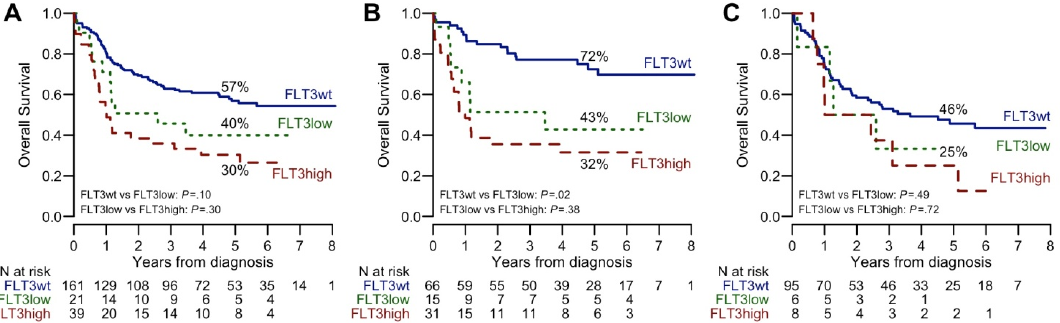
Figure 5. Kaplan-Meier curves of Overall Survival (OS), according to FLT3 -ITD ratio. ( A ) All patients; ( B ) NPM1 positive patients; ( C ) NPM1 wild-type patients. 5-year OS estimates and P values are